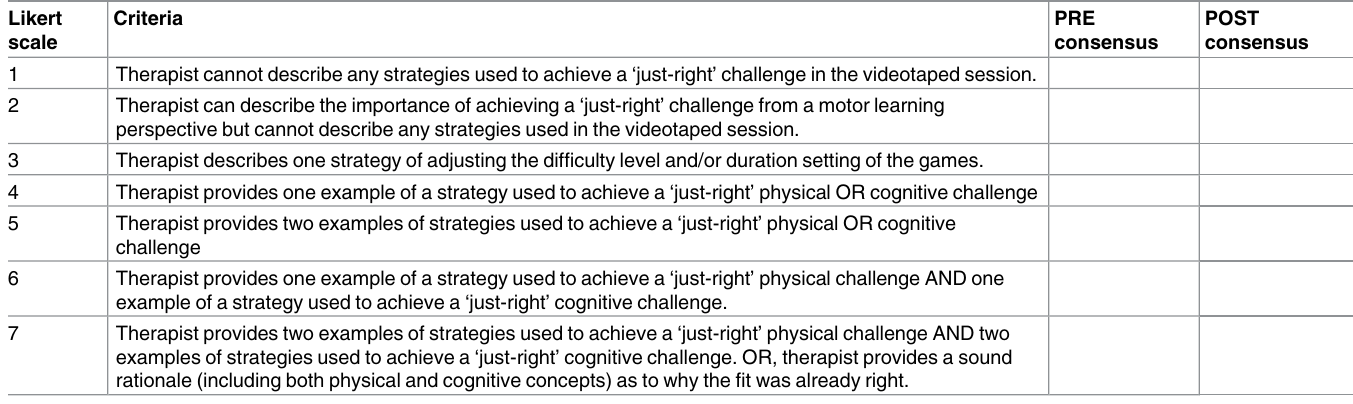
Table 2. Example of chart-stimulated recall grading criteria for competency 4. Likert scale